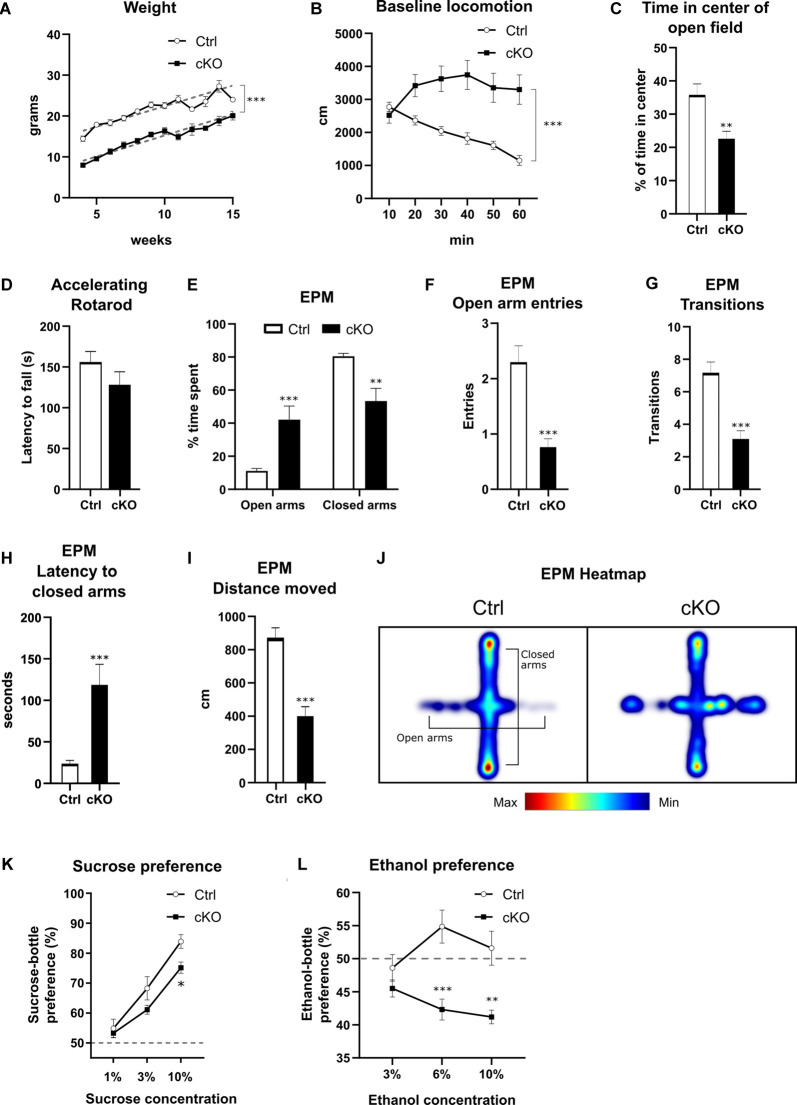
Behavioral characterization of cKO mice and littermate controls in various aspects of development and behavior. Weight curves (A) with lines of best fit (gray dashed lines). Horizontal locomotion during 60 min in a novel open field environment (B), analyzed for time spent in the center of the arena (C). Latency to fall from a rotarod at accelerating speeds (D). Various parameters measured in the elevated plus maze (E–I): the proportion of time spent in open vs. closed arms (E), number of entries into open arms (F), overall transitions in all compartments (G), latency to first enter closed arms (H), and distance moved during the test (I). Cumulative frequency of position on the apparatus visualized in a composite heat-map (J). Preference for a solution of either sucrose (K) or ethanol (L) over water. Data presented as mean ± SEM, *p < 0.05, **p < 0.01, ***p < 0.001.